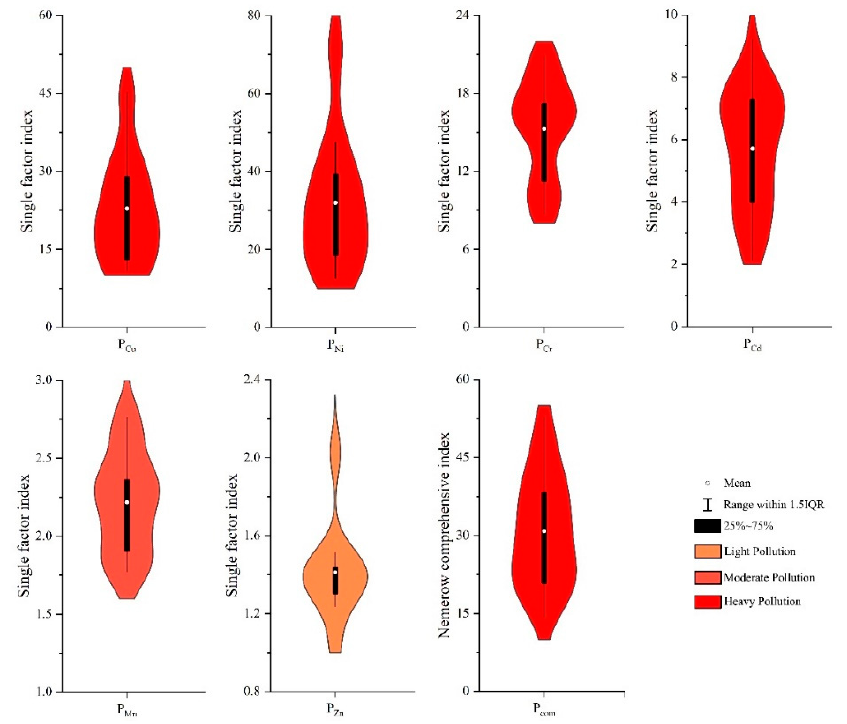
Figure 2. Statistical characteristics of soil heavy metal pollution indexes ( n = 30).